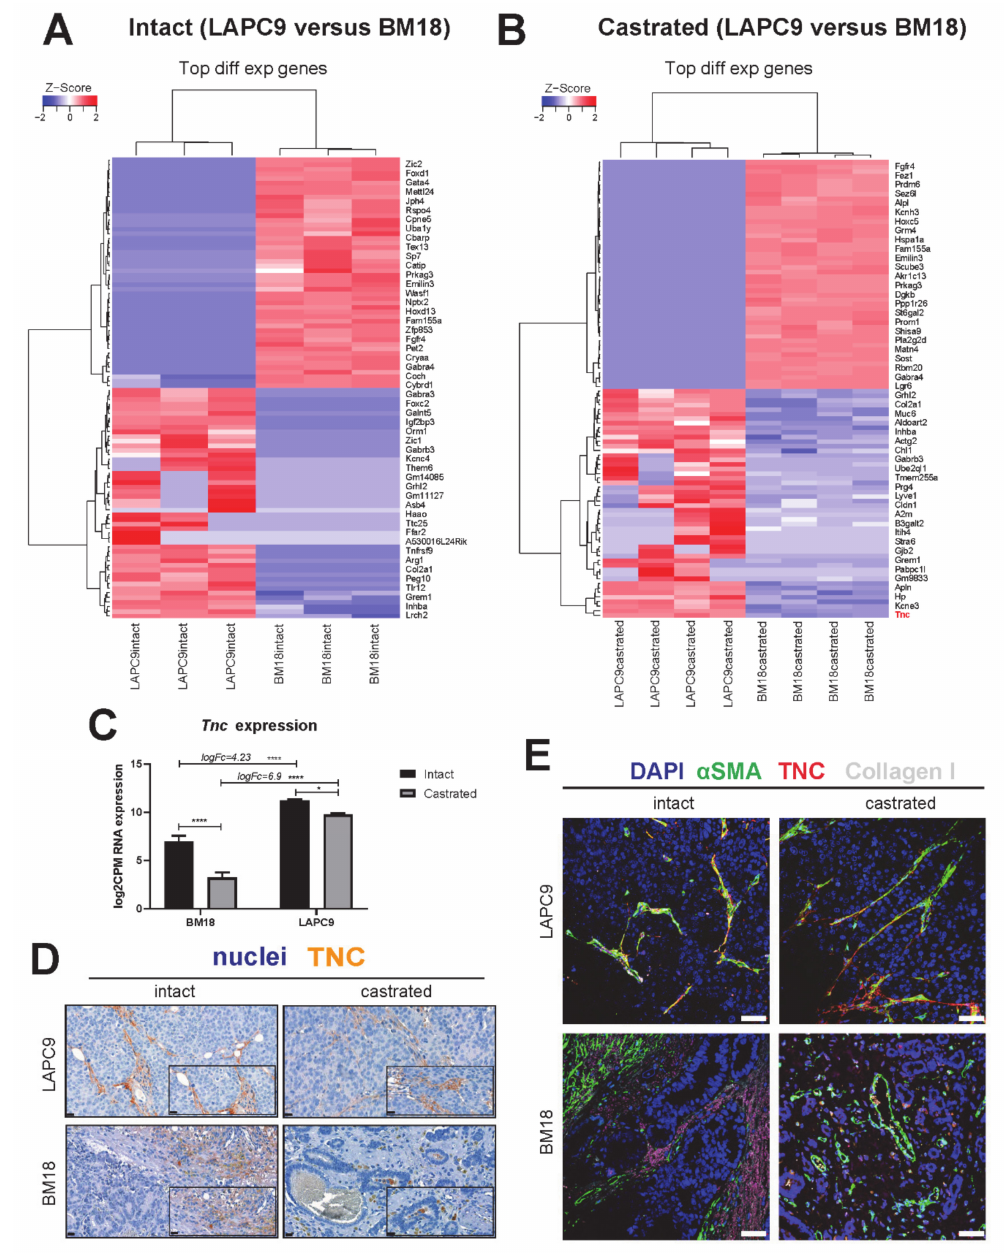
Figure 5. Cross-comparison of LAPC9 versus BM18 suggests stromal gene Tenascin C expression being associated with advanced PCa and regulated by androgen levels. ( A ) Heatmap represents the di ff erential expression analysis of the top 100 most variable genes from the mouse transcriptome of LAPC9 intact tumors compared to BM18 intact tumors and ( B ) of LAPC9 castrated tumors compared to BM18 castrated tumors. ( A ) Subset of genes in LAPC9 samples have zero counts, leading to the same z-score, while the same genes are highly expressed in BM18 samples. ( C ) Tnc RNA expression (log 2 CMP counts) in the stroma transcriptome. Log FC (fold change) enrichment of Tnc in LAPC9 over BM18 is indicated. Ordinary two-way ANOVA with Tukey’s multiple comparison correction was performed, p < 0.05 (*) and p < 0.0001 (****). ( D ) Tenascin protein expression and stromal specificity assessed by immunohistochemistry in LAPC9 and BM18 tumors, both at the intact and castrated states. Scale bars: 20 µ m. ( E ) Tenascin protein (indicated in red) colocalization with stromal markers, smooth muscle actin ( α SMA, green) and collagen type I (gray) assessed by immunofluorescence in LAPC9 and BM18 tumors, both at the intact and castrated states. DAPI marks the nuclei. Scale bars: 50 µ